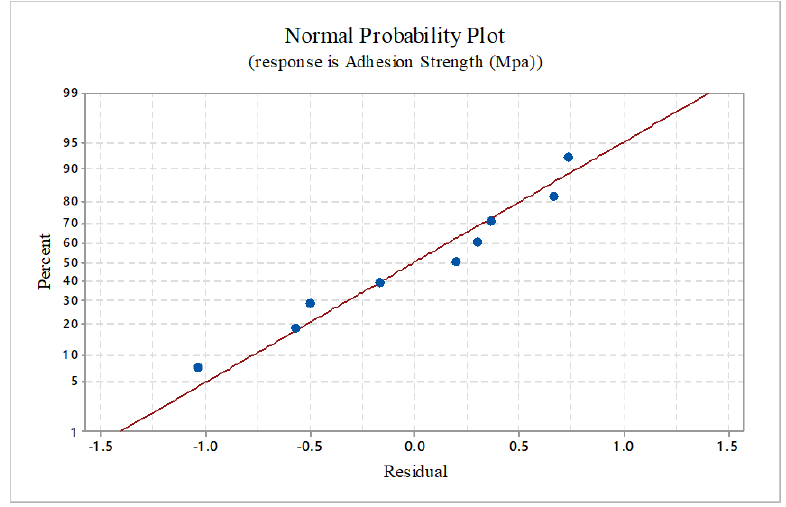
Figure 7. Normal probability plot.